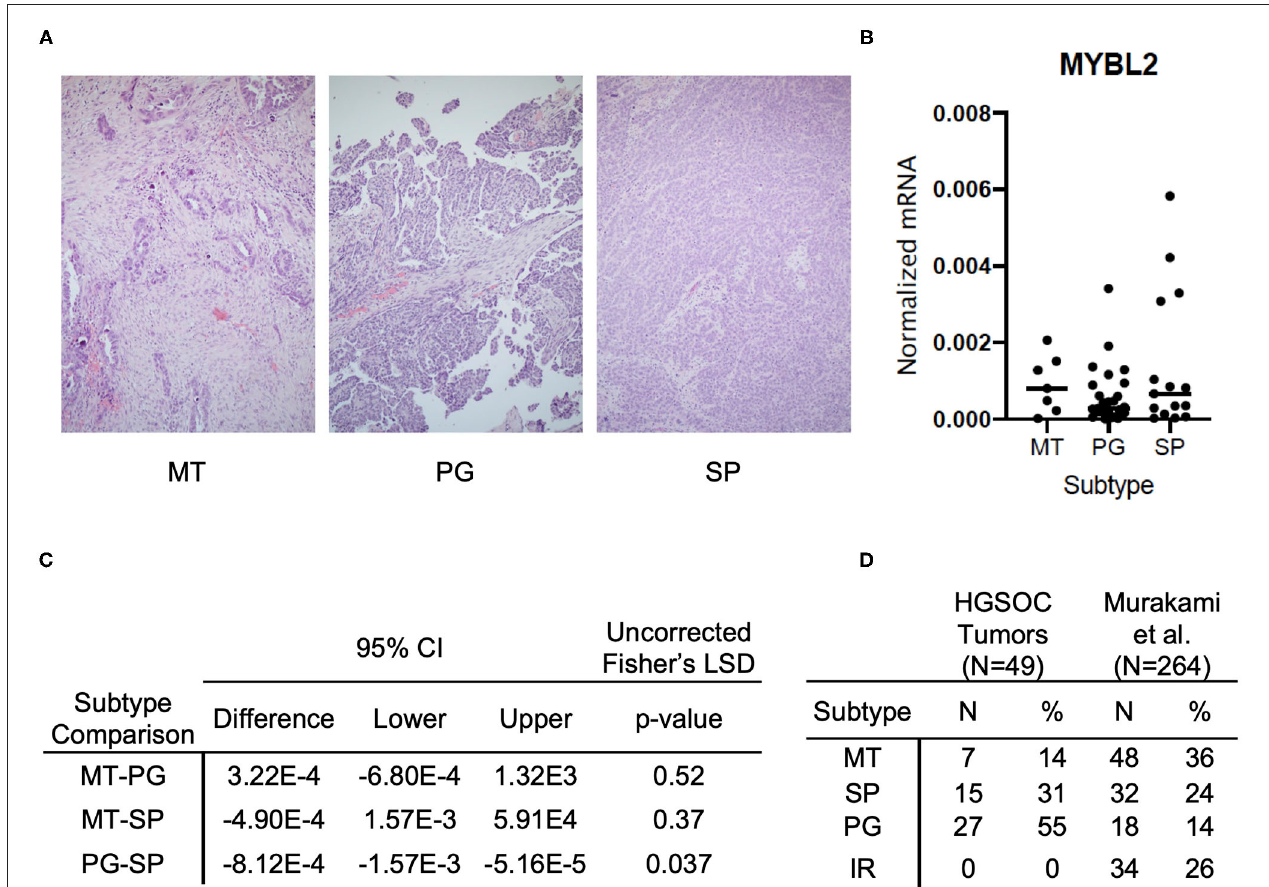
FIGURE 3 | MYBL2 expression varies by histological subtype and is associated with morphological evidence of cell proliferation. (A) Representative H&E sections of respective histological subtypes at 4 × magnification. (MT) Mesenchymal Transition subtype characterized by prominent desmoplastic reaction ( N = 7). (PG) Papilloglandular subtype with predominance of papillary architecture ( N = 27). (SP) Solid and Proliferative subtype characterized by solid tumor nests with rounded contours ( N = 15). The immune reactive (IR) subtype, defined by rounded contours and infiltrative lymphocytes, was absent in our samples. (B) Graph shows comparison of MYBL2 expression across HGSOC primary tumor samples ( N = 49) grouped by histological subtype (C) Analysis of differential MYBL2 expression across histological subtypes. Uncorrected Fisher’s least significant difference, p < 0.05. (D) Table showing distribution of samples across subtypes alongside those in the original study by Murakami et